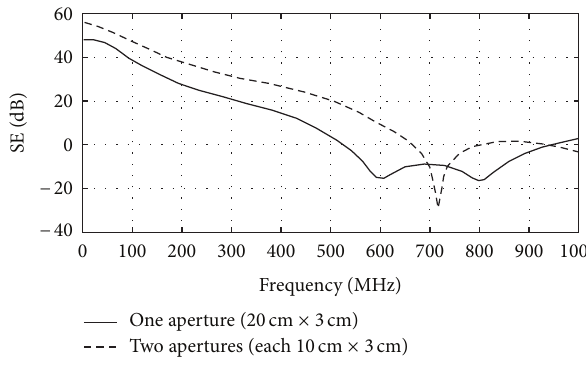
F 9: Shielding effectiveness versus frequency for a box-shaped enclosure of dimensions 30 different values of the aspect ratio and having the same area.